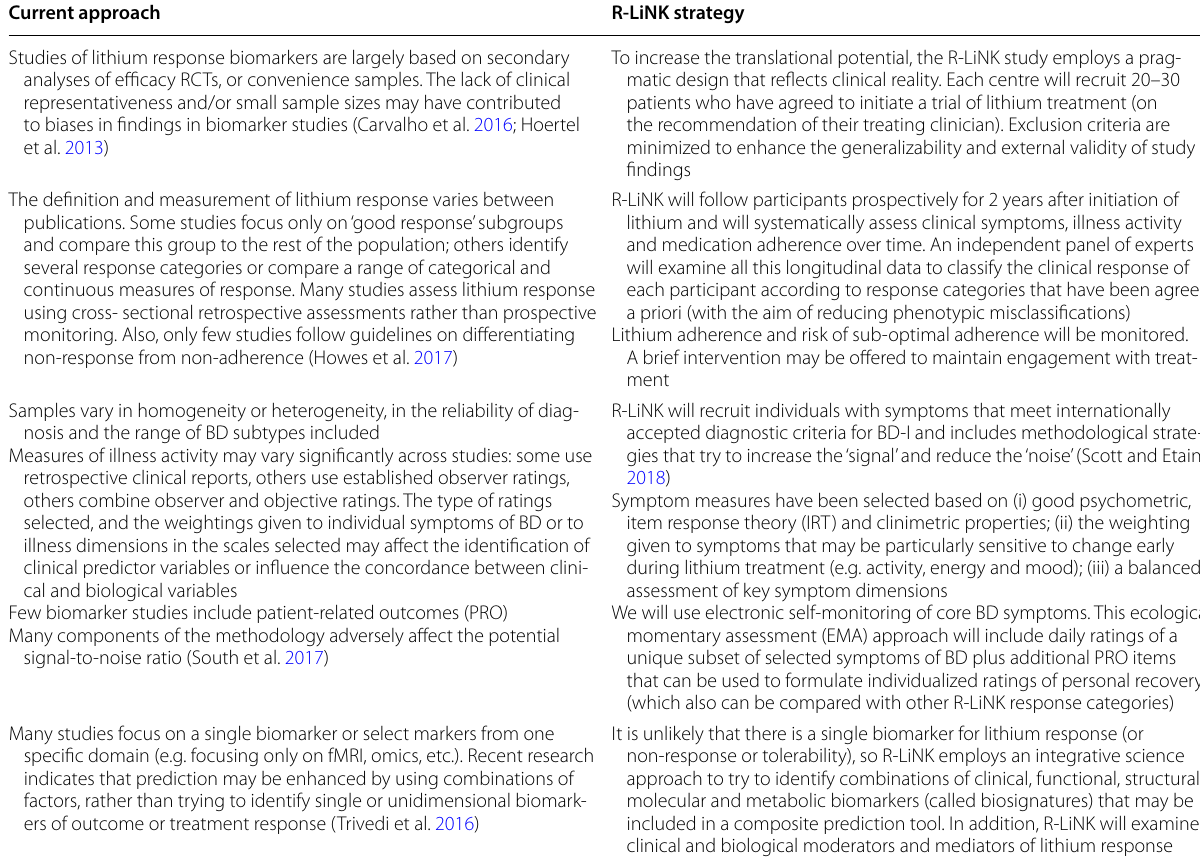
Table 1 Summary of approaches used by current studies of precision psychiatry compared with the R‑LiNK study